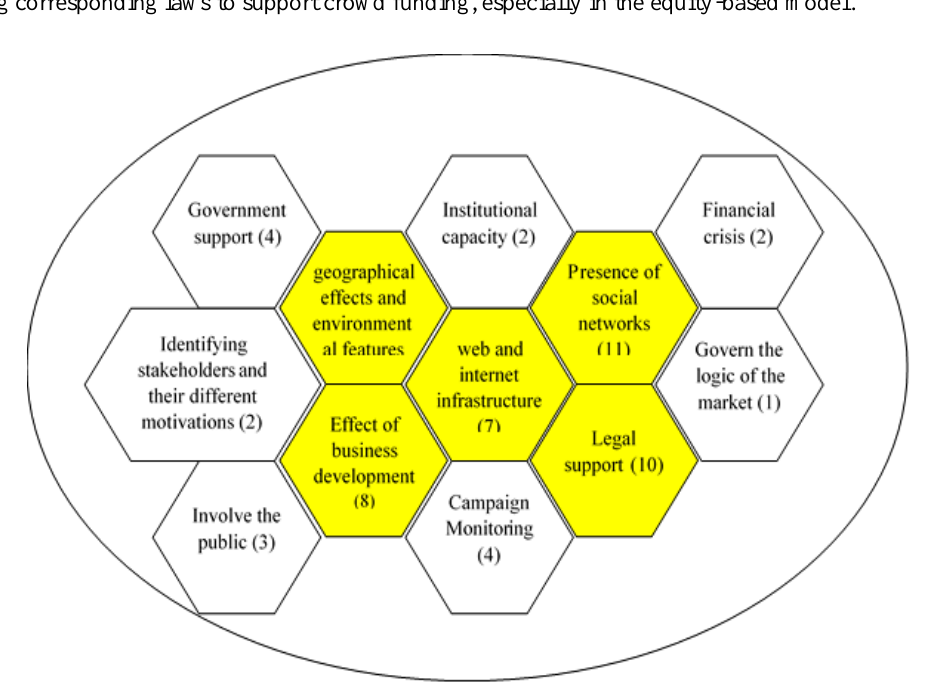
Figure 13. Clustering hexagons associated with other